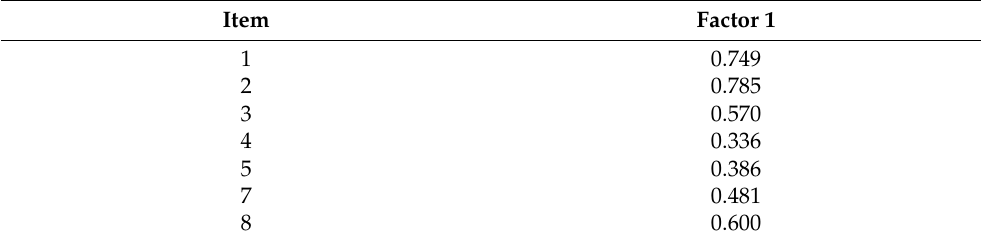
Table 2. Pattern matrices of the risk perception of the ABR scale (EFA—Principal Component Analysis).